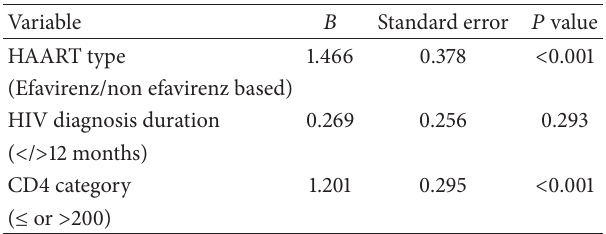
Table 2: Demographic and clinical characteristics of patients with poor and good quality sleep.